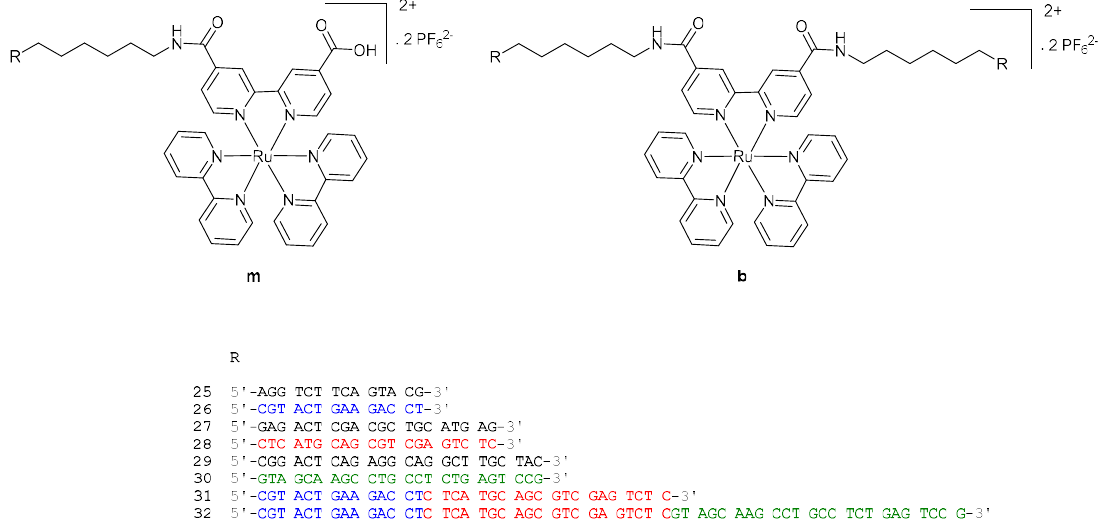
Figure 10. Structures of m25 – m32 mono Ru-DNA and b25 – b32 bis Ru-DNA.